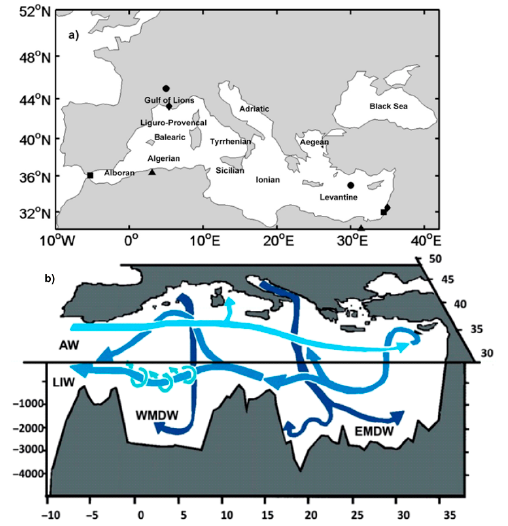
Figure 1. ( a ) Map of the Mediterranean Sea with the main basins and sub-basins. Symbols indicate the locations selected for measuring pressure differences in the station-based Mediterranean Oscillation (MO) indices (a triangle for Algiers–Cairo, a square for Gibraltar–Israel, a circle for France–Levantine and a diamond for Marseille–Jerusalem); ( b ) Sketch of the Mediterranean thermohaline